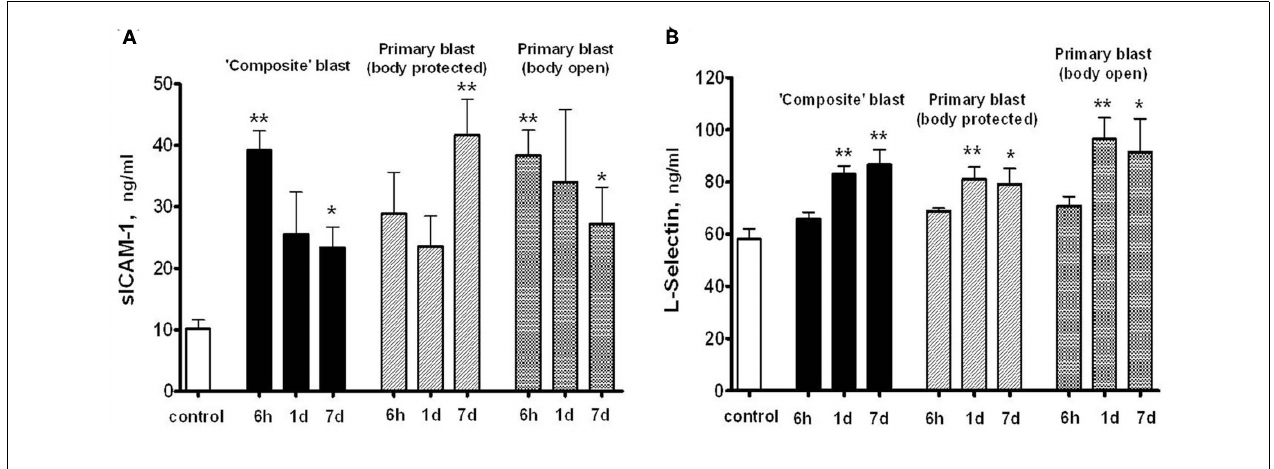
analyze statistical significance of values. Data shown are mean ± SEM of at least three independent experiments.